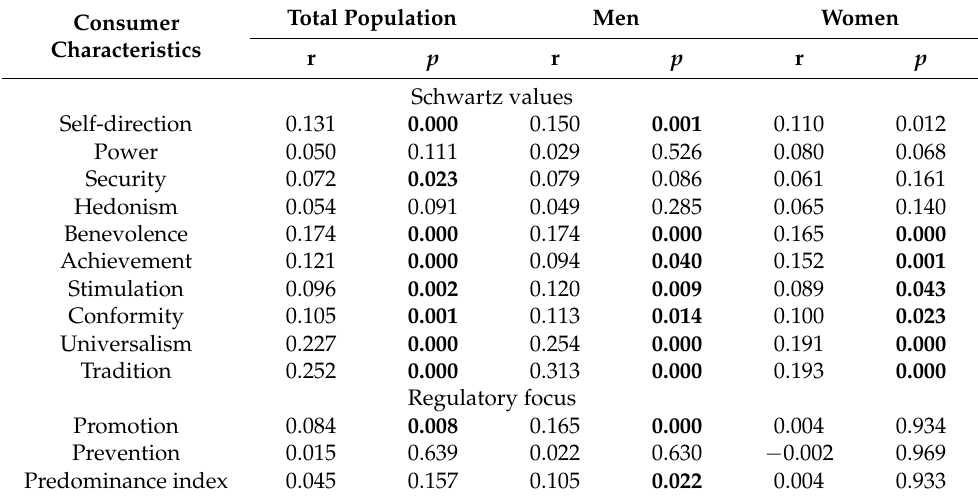
Table 5. Pearson correlation coefficients of the willingness to pay a price premium for the Polish origin of food products with the Schwartz values and regulatory focus by